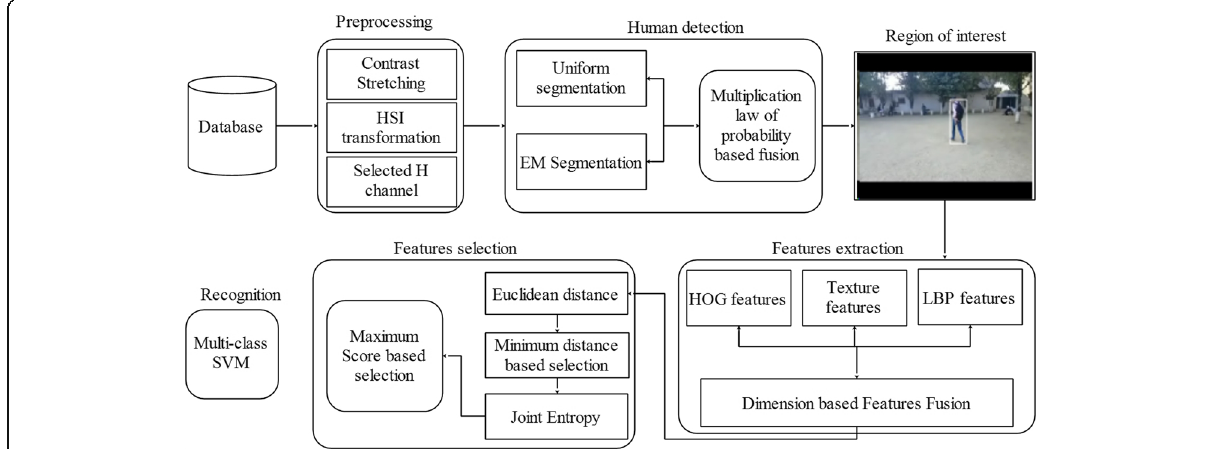
Fig. 2 A framework of proposed human detection and action classification